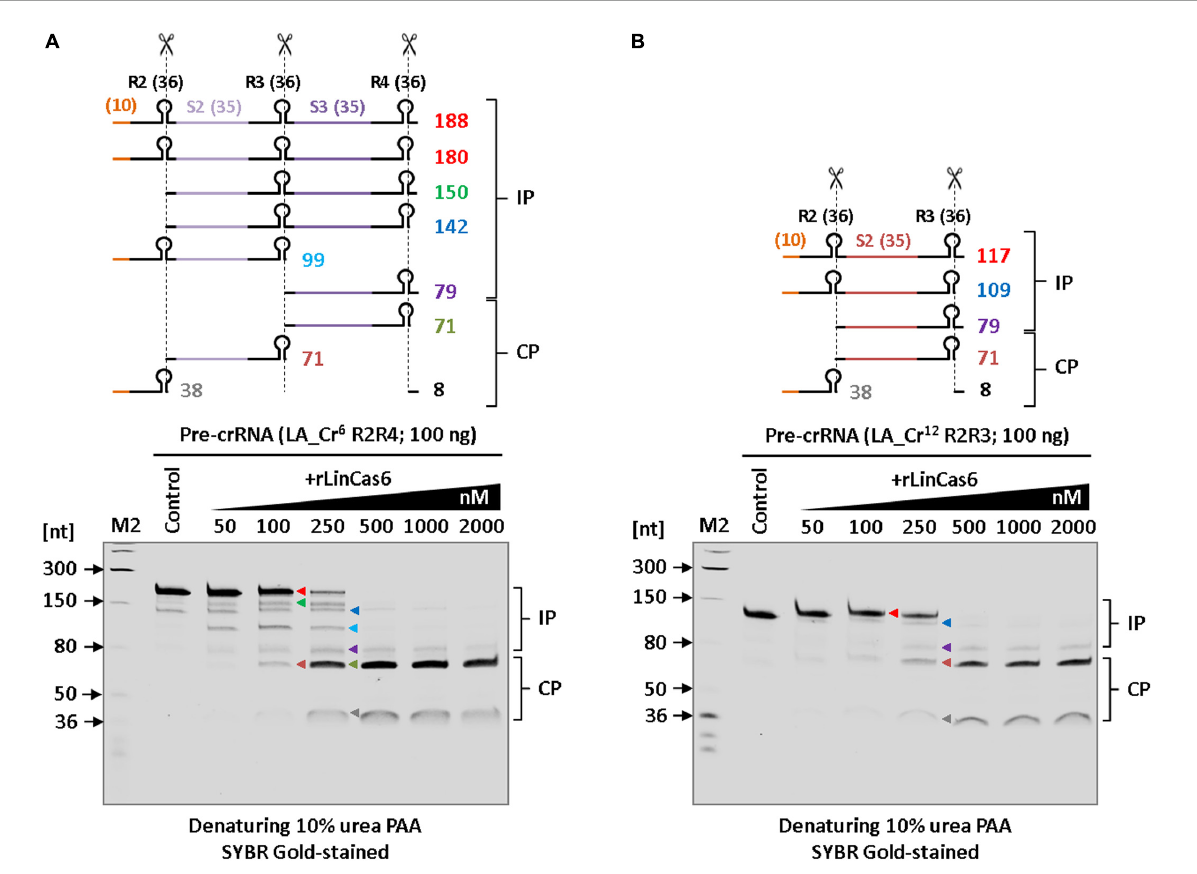
FIGURE4 In vitro processing of the miniature CRISPR I-B transcript of serovar Lai with rLinCas6 endoribonuclease. (A) Nuclease activity of rLinCas6 on pre-crRNA of LA_Cr 6 . In vitro synthesized LA_Cr 6 miniature transcript (R2R4; 188 nt) was incubated with increasing concentrations of rLinCas6 (50–2,000 nM). The possible pre-crRNA derived cleaved fragments ( n = 9) by rLinCas6 are illustrated as incompletely processed (IP; n = 5) and completely processed (CP; n = 4) fragments (top panel). The reaction products were analyzed on denaturing urea gel after staining with SYBR Gold. At 100 to 250 nM of rLinCas6, six bands of different molecular lengths, each marked with unique color, were detected (bottom panel). (B) Nuclease activity of rLinCas6 on miniature pre-crRNA of LA_Cr 12 (R3R4). IP and CP fragments on the gel were mapped and indicated right to the gel images. Repeats and spacers are shown by black and unique colors, respectively, in the pre-crRNA outline. The orange line denotes a vector-derived additional 10 nt at its 5 (cid:48) end of each pre-crRNA. All reactions, including controls (no protein), were incubated for 1 h at 37 ◦ C. “M2” denotes RNA markers used for the size estimation of RNA fragments observed on the